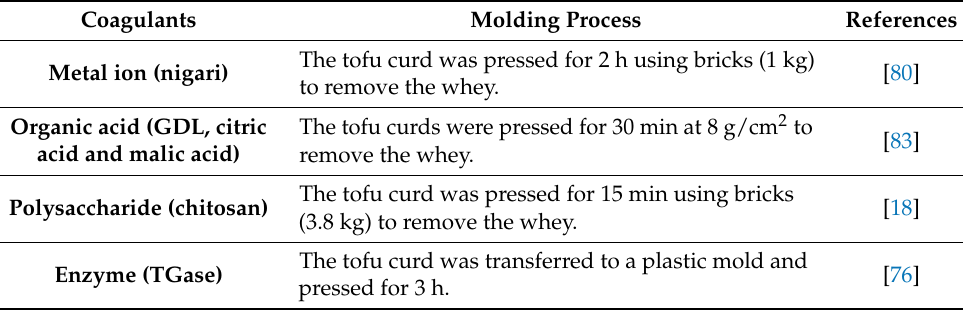
Table 4. The processes of molding coagulated soybean proteins in